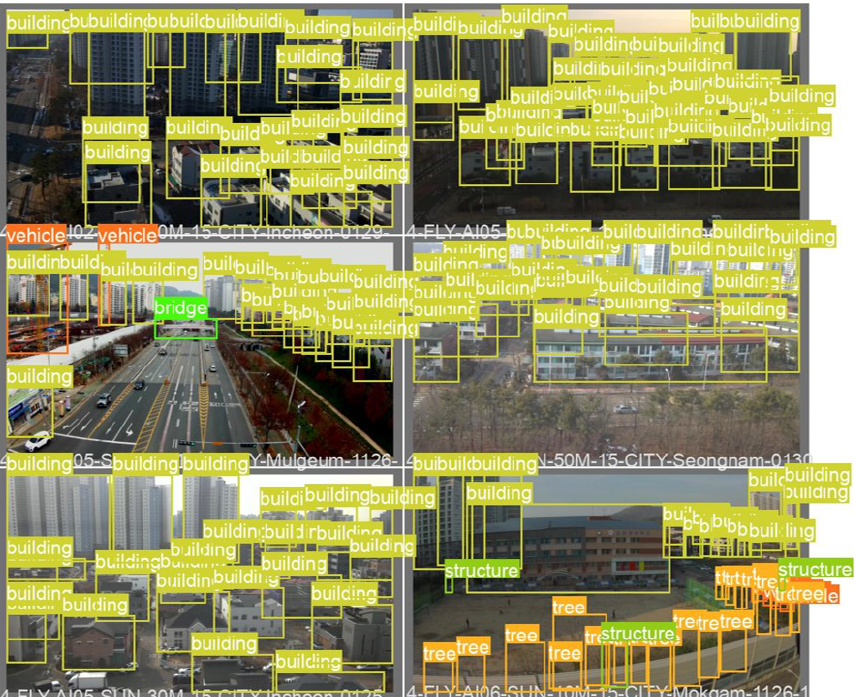
Figure 5. The result of object detection on VAF. The objects detected by VAF mainly consist of trees and